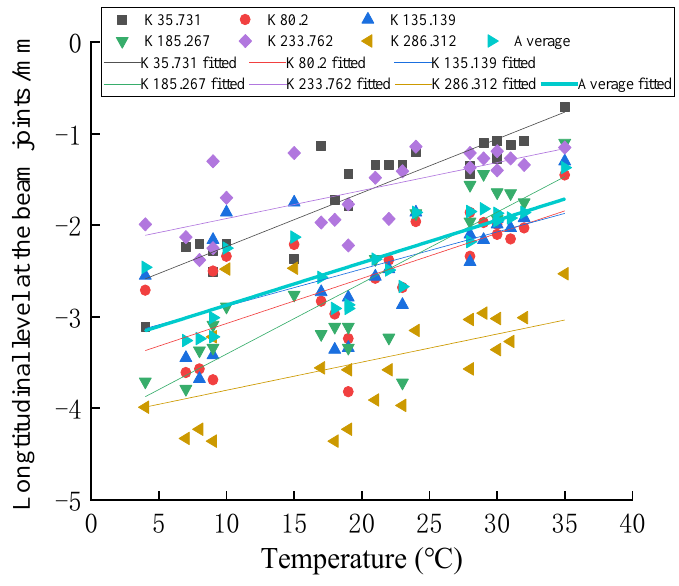
Figure 6. Variation of the longitudinal level at the beam joint with temperature.